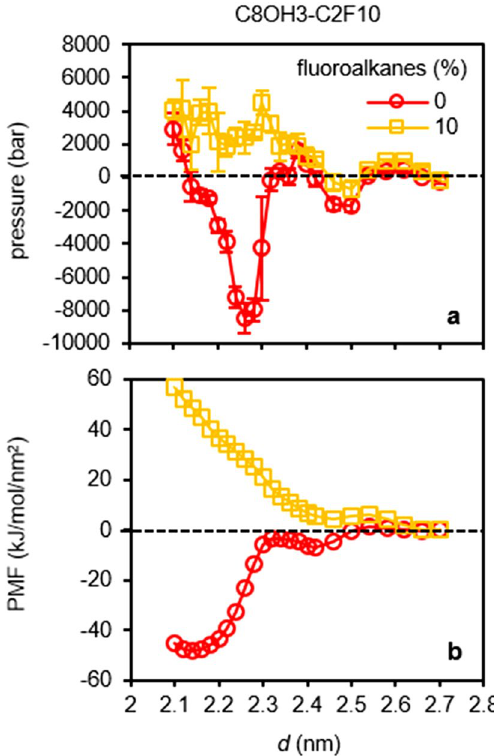
Figure 5. Pressure-distance curves ( a ) and PMF ( b ) for the C8OH3-C2F10 SAM-calcite interactions with different percentages of fluoroalkanes. The pressure-distance curves show a weaker adhesion distance at d = 2.5 nm and a very strong adhesion distance at d = 2.26 nm. The PMF show a nonstick surface with only 10% C2F10 in a bicomponent SAM.